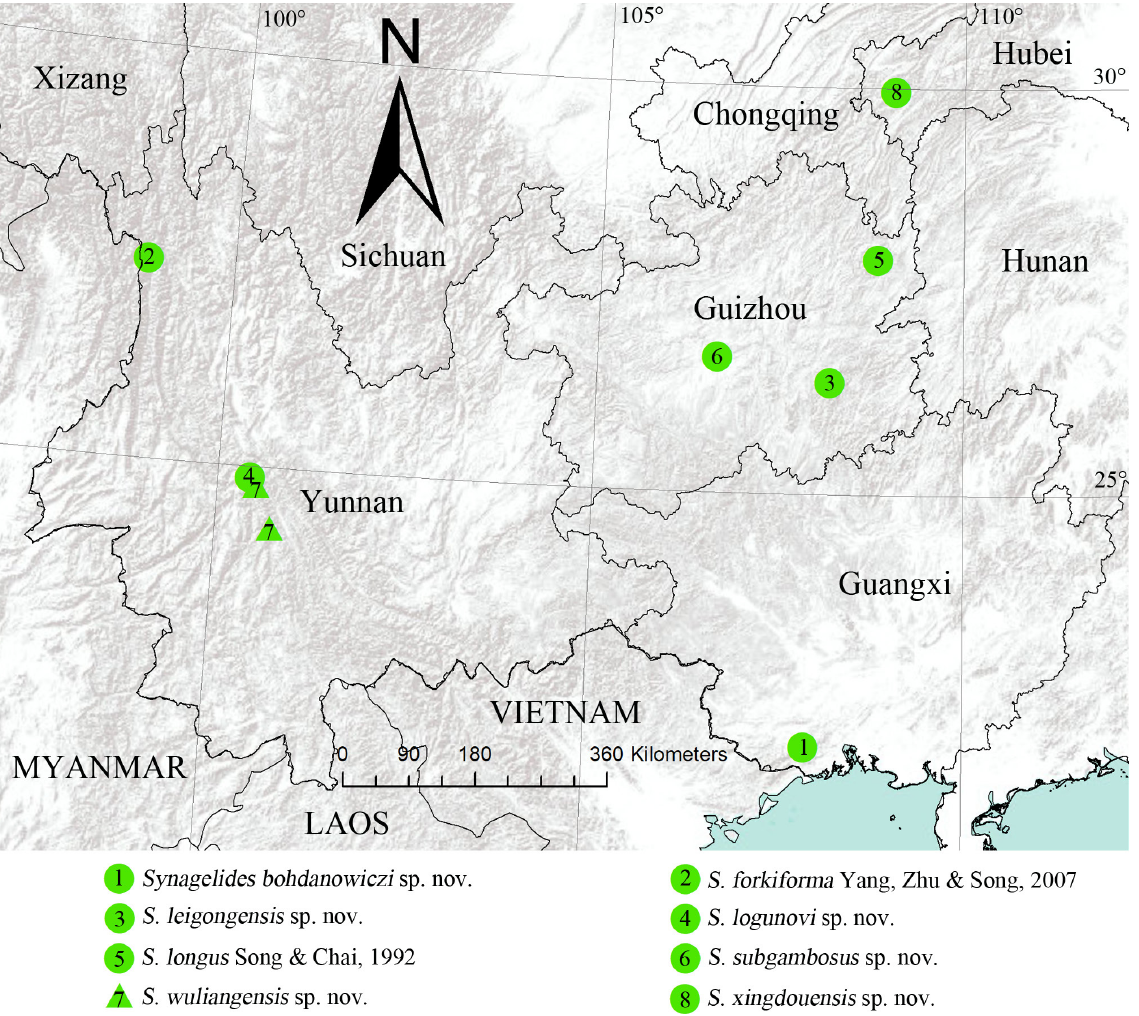
Fig. 18. Distributional map of eight species of Synagelides Strand, 1906: S. bohdanowiczi sp. nov.; S. forkiforma Yang, Zhu & Song, 2007; S. leigongensis sp. nov.; S. longus Song & Chai, 1992; S.